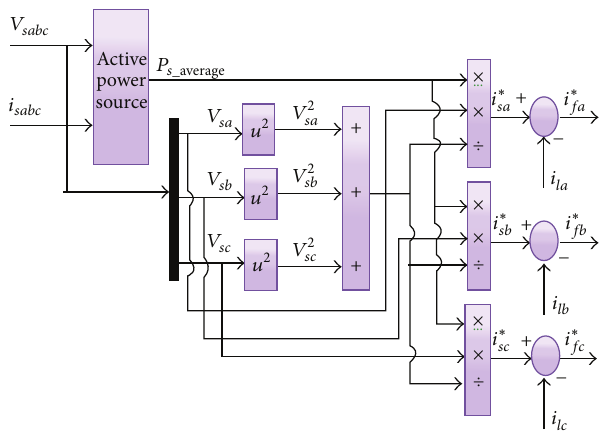
Figure 2: Block diagram of the proposed control